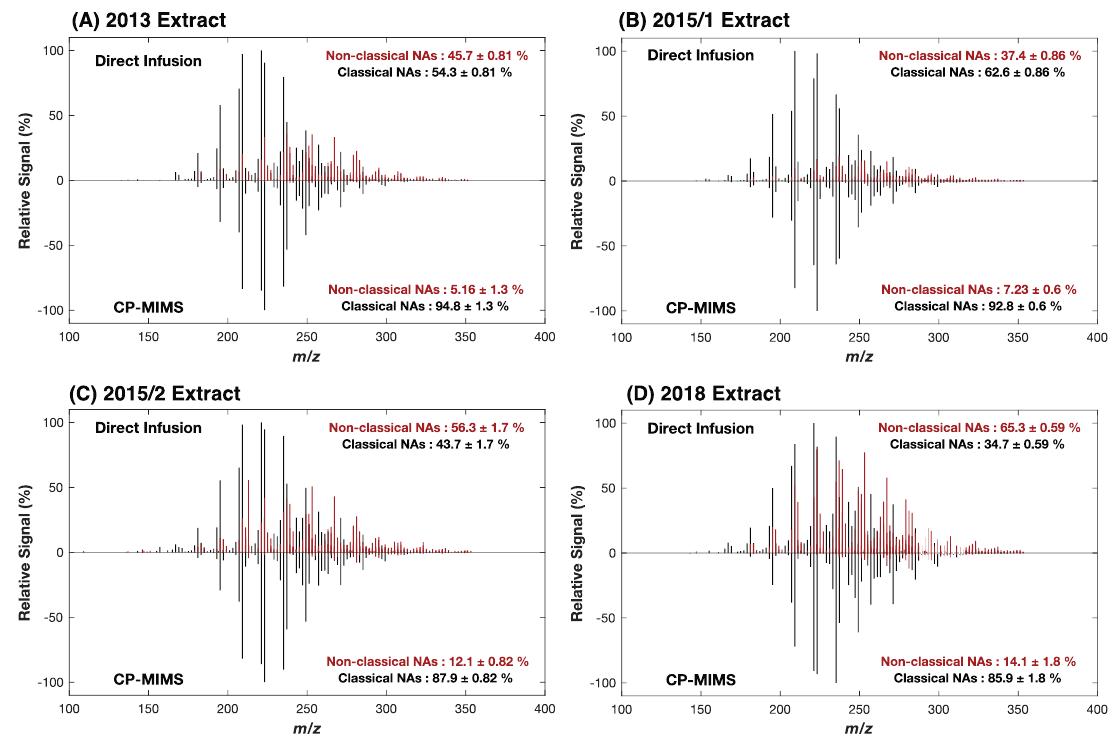
Figure 2. Enrichment of O 2 class NAs using CP-MIMS for 4 OSPW extracts. Full scan HRMS spectra of the [M-H] - of OSPW-NA extract showing O 2 class (black) and all other NAFCs (O 3-7 , N, S; red) for direct infusion (upper panels) and CP-MIMS (lower panels). The directly infused spectra are comprised of only ca. 30–65% O 2 class NAs by overall signal intensity, while this rises to >85% in the membrane permeate. Spectra are averaged over a triplicate series and overall assignments are presented with the standard deviation across the triplicate set.